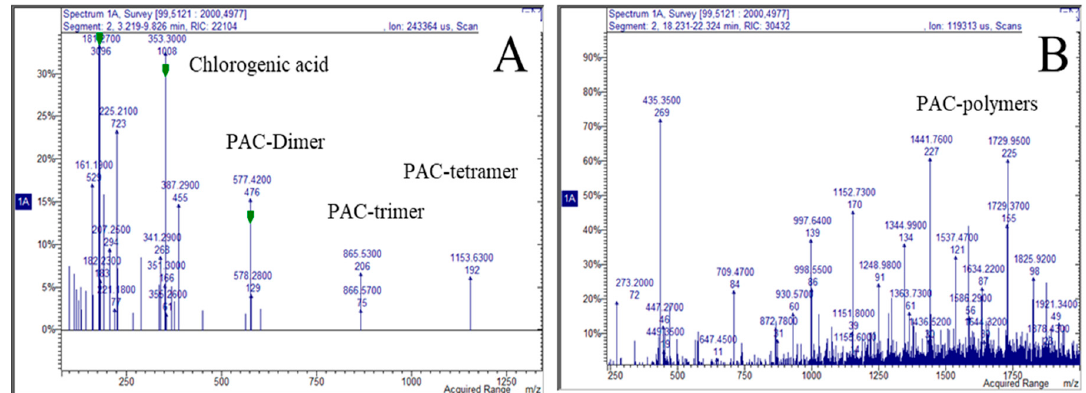
Figure 3. Cumulative spectra obtained from the chromatogram regions 3–10 min ( A ) and 18–22 min ( B ) showing the relative intensity of m / z species corresponding to different (proanthocyanidin) PAC species.